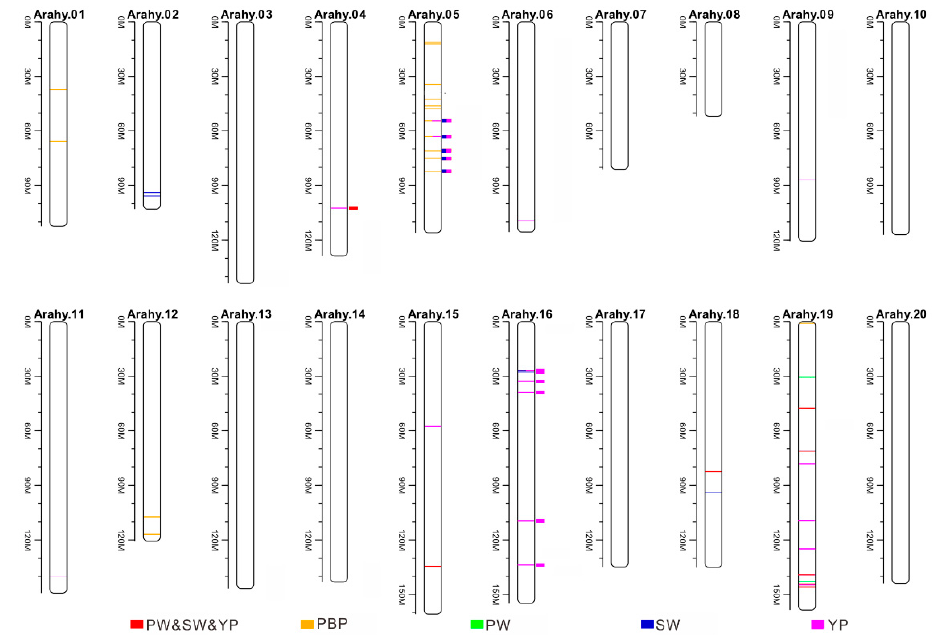
Figure 5. Quantitative trait loci (QTLs) identified to be associated with yield-related traits by both the current GWAS and earlier QTL mapping studies. The orange, green, blue, and magenta colors, respectively, for the yield-related traits PBP, PW, SW, and YP. The colorful lines represent the QTLs identified by the present study, the solid squares point to the QTLs that are co-localized with earlier identified QTLs. Most of these co-localized QTLs are located on chromosomes Arahy.05 and Arahy.16.